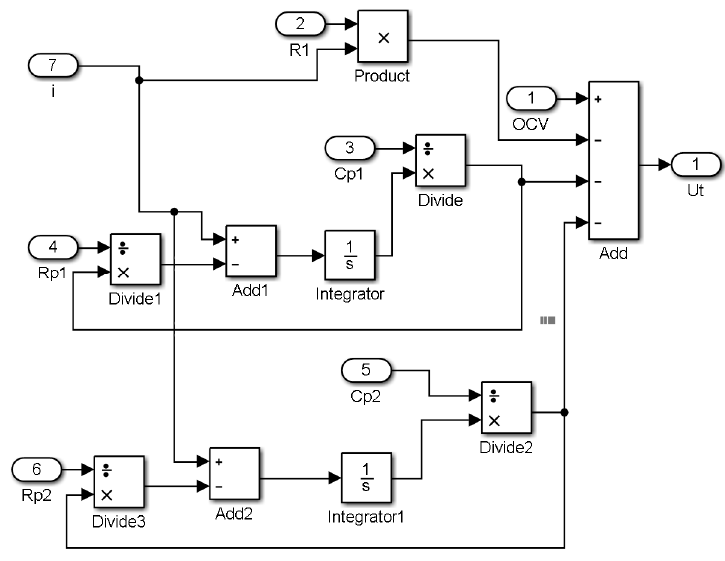
Figure 10. The terminal voltage calculation submodule of the second-order RC model for Simulink simulation.